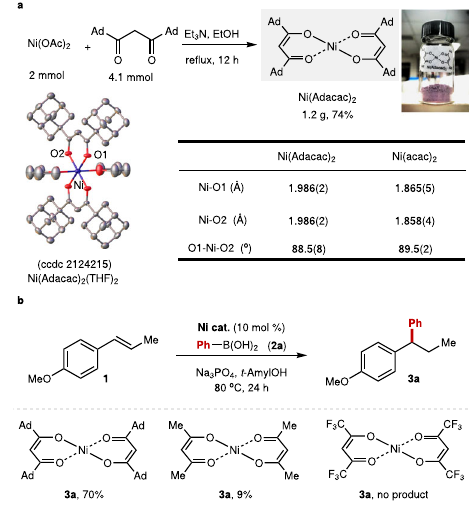
Fig. 7 | Synthesis of Ni(Adacac) 2 complex and its reactivity. a Synthesis of Ni(Adacac) 2 complex. b Reactivity of Ni(Adacac) 2 in Ni-catalyzed hydroarylation